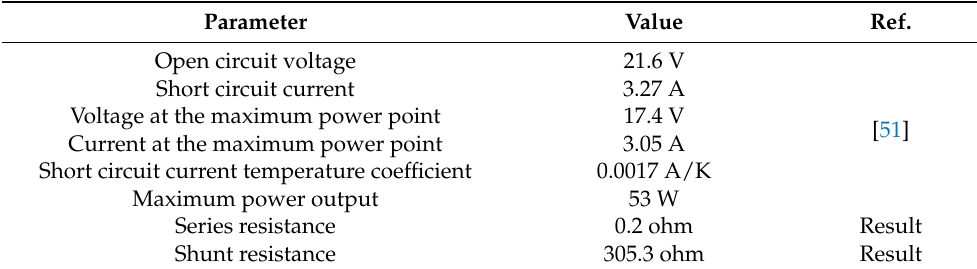
Table 3. Design parameters of the photovoltaic